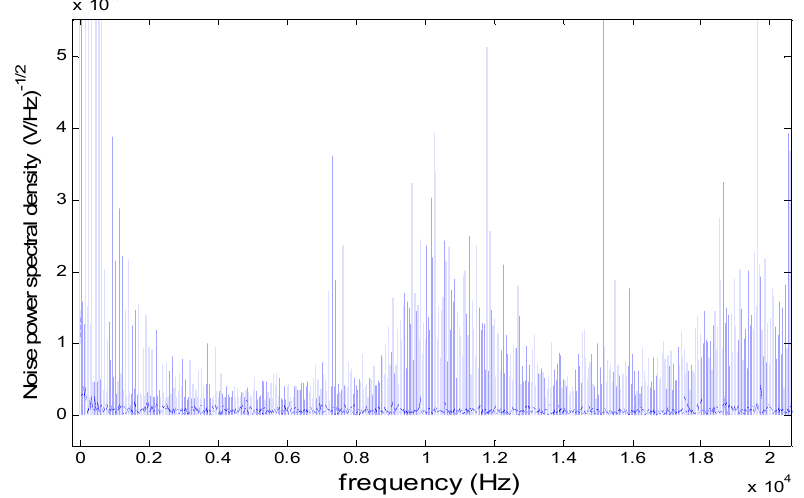
Figure 24. Spectral noise measured when the PSD sensor was not illuminated (image corresponds to channel 1).